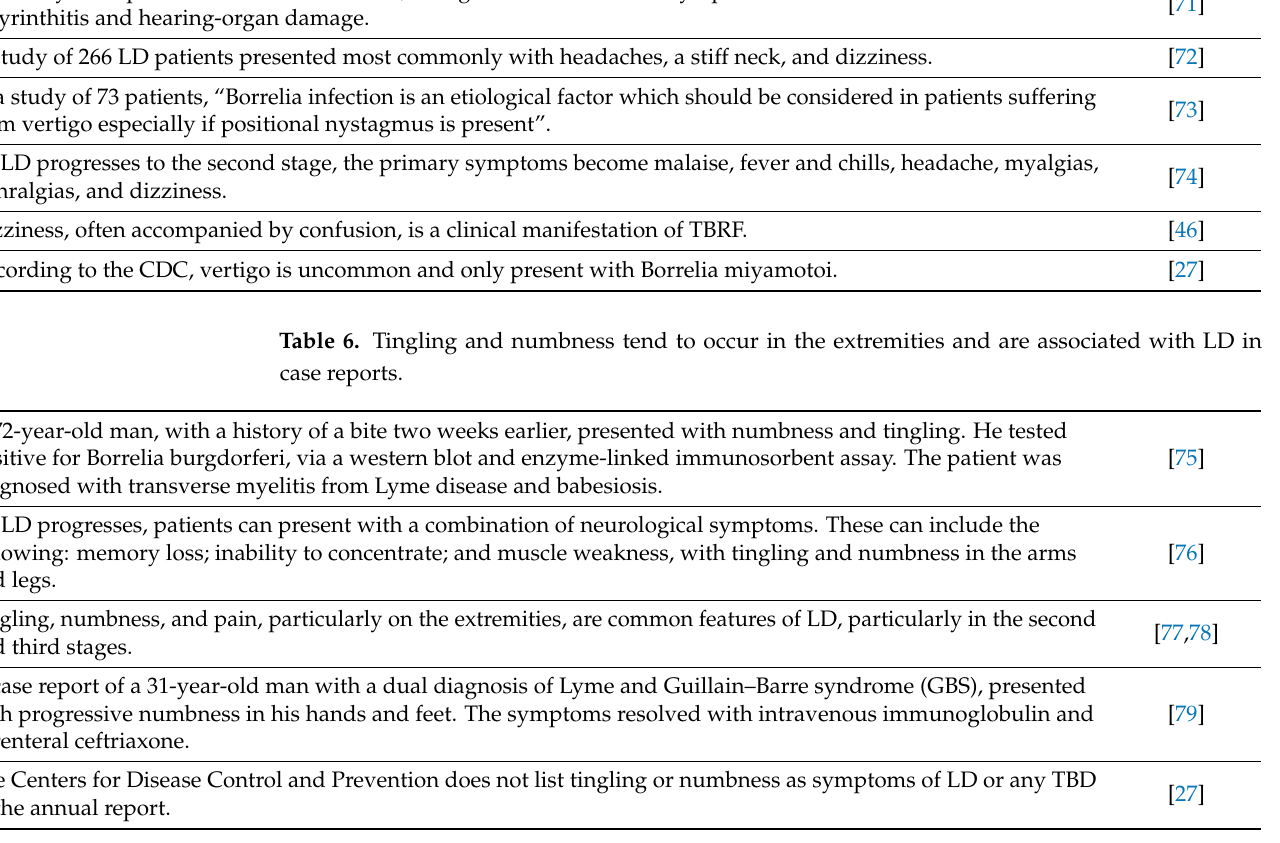
Table 7. Cognitive function (concentration, word finding, and memory difficulty)–limited